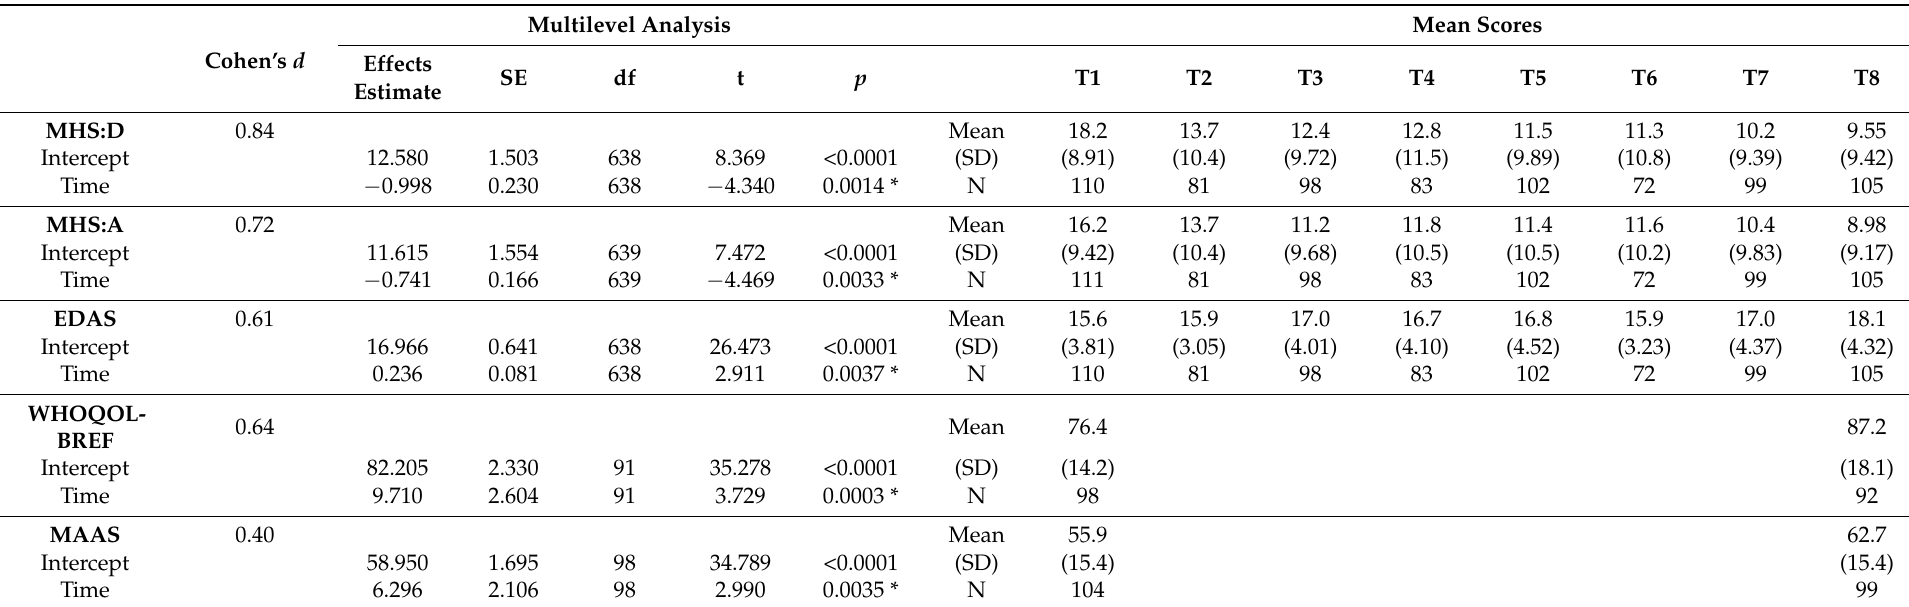
Table 2. Effect sizes (Cohen’ d ), the result of multilevel analysis, and mean scores of five mental health